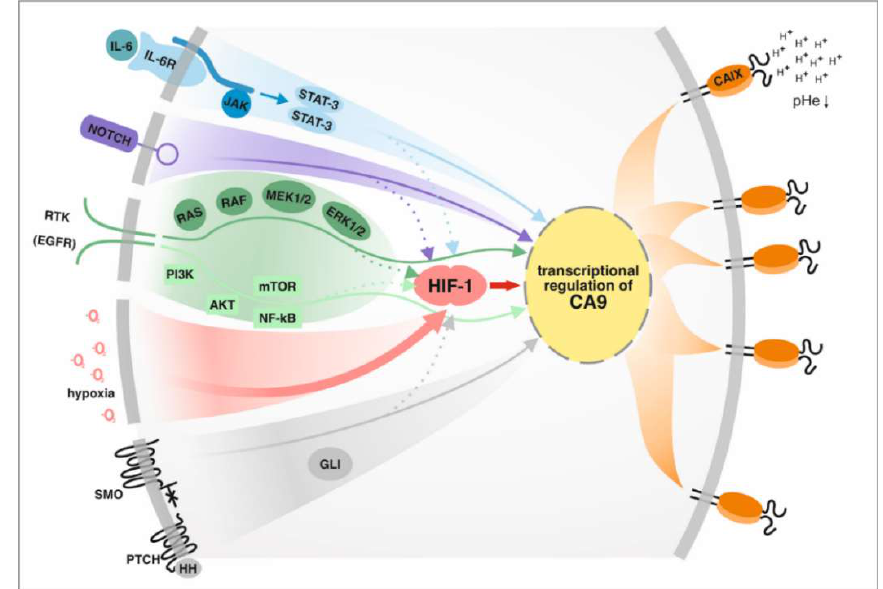
Figure 2. Schematic presentation of signaling pathways activated in pancreatic cancer and their effect on CA9 expression.